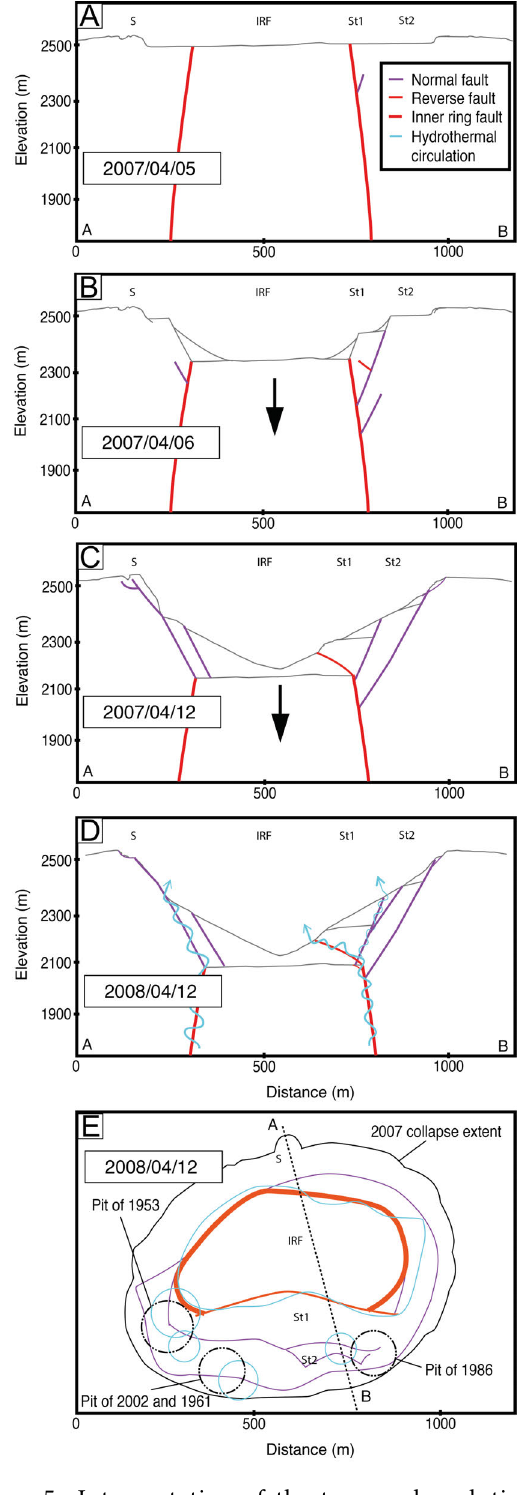
Figure 5: Interpretation of the temporal evolution